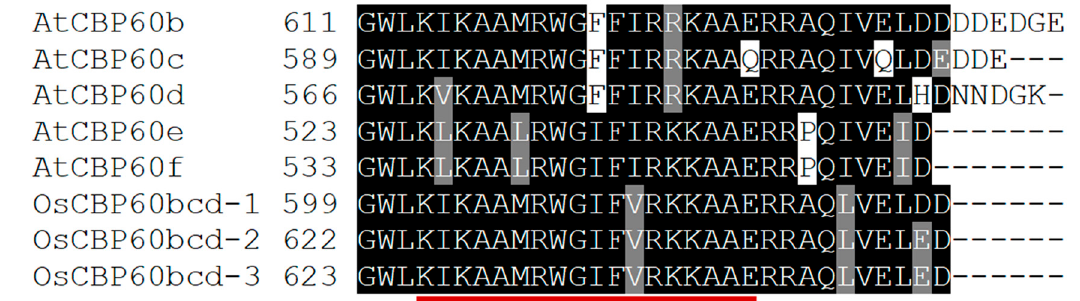
Figure 3. Multiple sequence alignment of the predicted CBDs of AtCBP60b, c, d, e, and f and their putative rice orthologs OsCBP60bcd -1, 2, and 3. The alignment was carried out in CLUSTAL Omega and displayed using Boxshade. The underlined sequence indicates the CBD in Arabidopsis proteins. Black shading indicates residues conserved in over 50% of the sequences; grey shading indicates semi-conservative substitutions while no shading indicates the lack of any similarity.